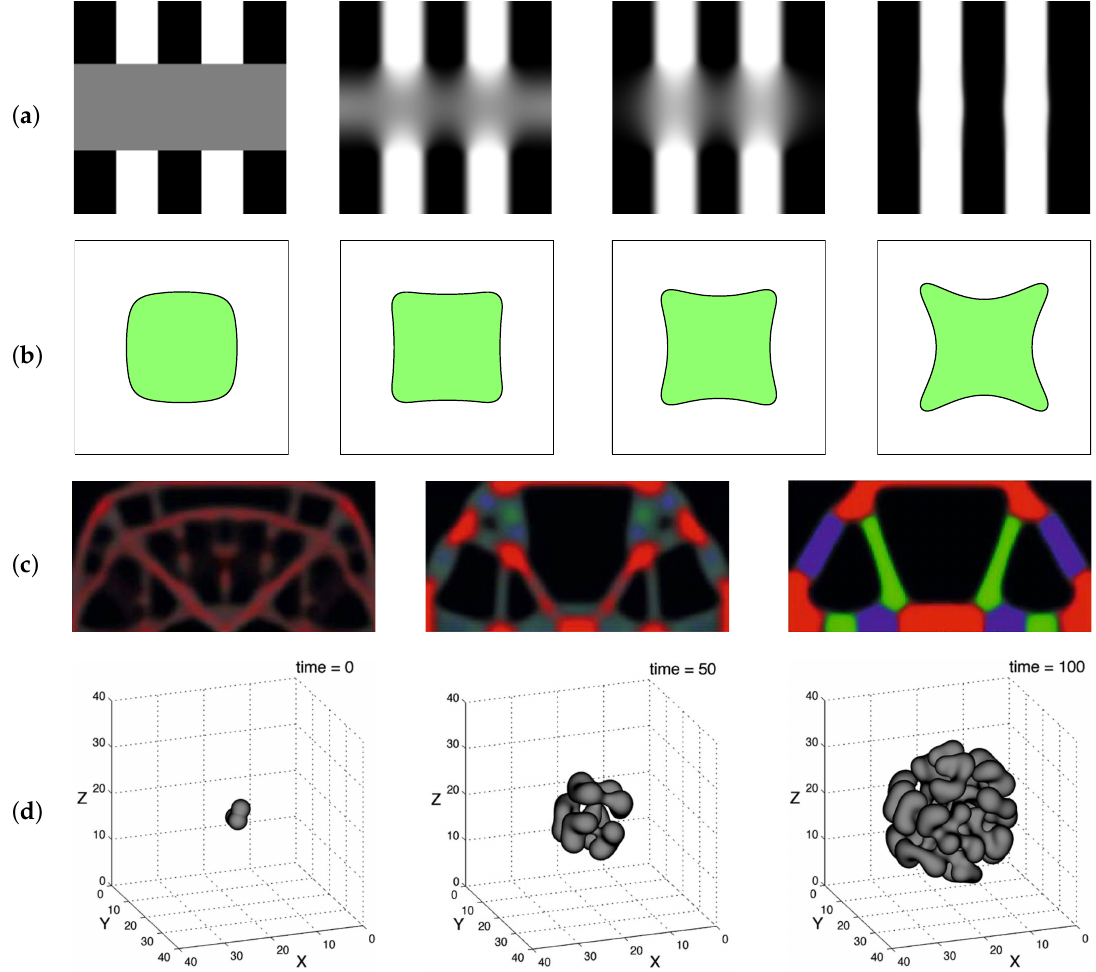
Figure 5. ( a ) Image inpainting, ( b ) microstructures with elastic inhomogeneity, ( c ) topology optimization, and ( d ) tumor growth simulation. Reprinted from [10] with permission from